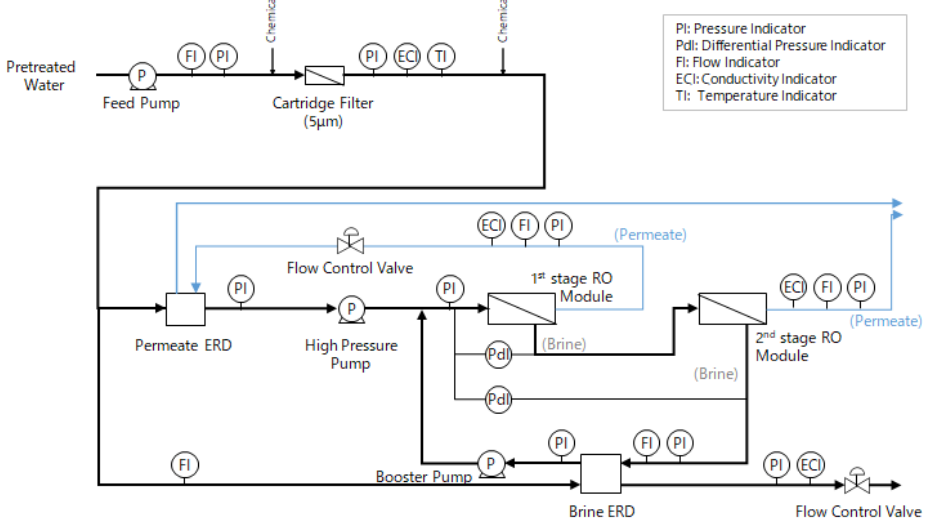
Figure 3. Flow diagram of reverse osmosis (RO) system.